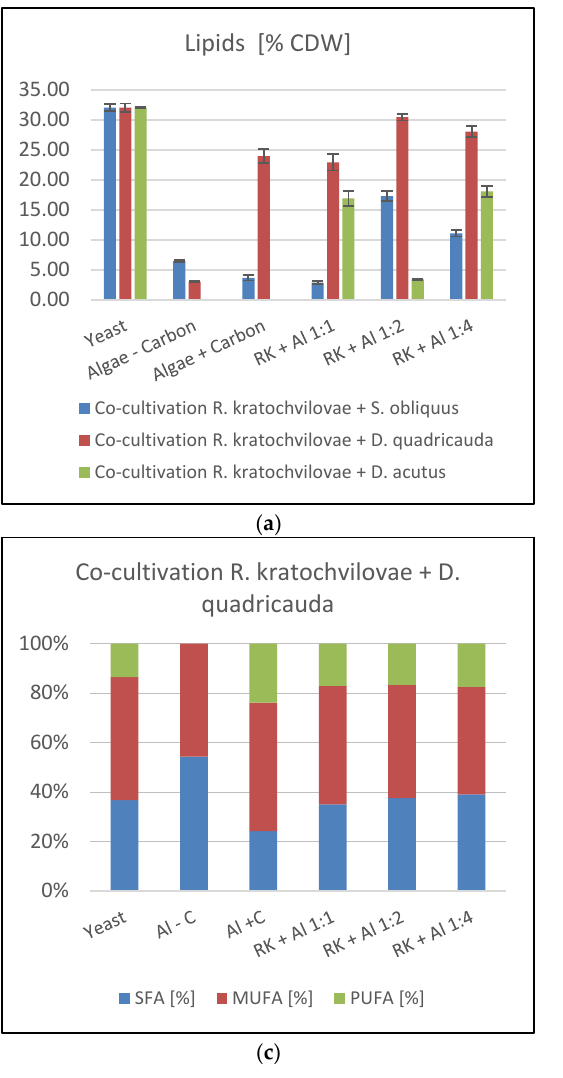
Figure 4. R. kratochvilovae lipid production and fatty acid profile in co-cultivation experiments in aerated Pyrex flasks. ( a ) — Total lipid production in all co-cultivations [%]; ( b ) — FA profile Co-cultivation R. kratochvilovae + S. obliquus ; ( c ) — FA profile Co-cultivation R. kratochvilovae + D. quadricauda ; ( d ) — FA profile Co-cultivation R. kratochvilovae + D. acutus . Abbreviations: Yeast — Rhodotorula kratochvilovae control cultivation; Algae − C — pure microalgae cultivation on BBM media without carbon source; Algae + C — pure microalgae cultivation on BBM media with carbon source; RK + AL 1:1 — co-cultivation of Rhodotorula kratochvilovae with microalgae with inoculation ratio 1:1; RK + AL 1:1 — co-cultivation of Rhodotorula kratochvilovae with microalgae with inoculation ratio 1:2; RK + AL 1:1 — co-cultivation of Rhodotorula kratochvilovae with microalgae with inoculation ratio 1:4.